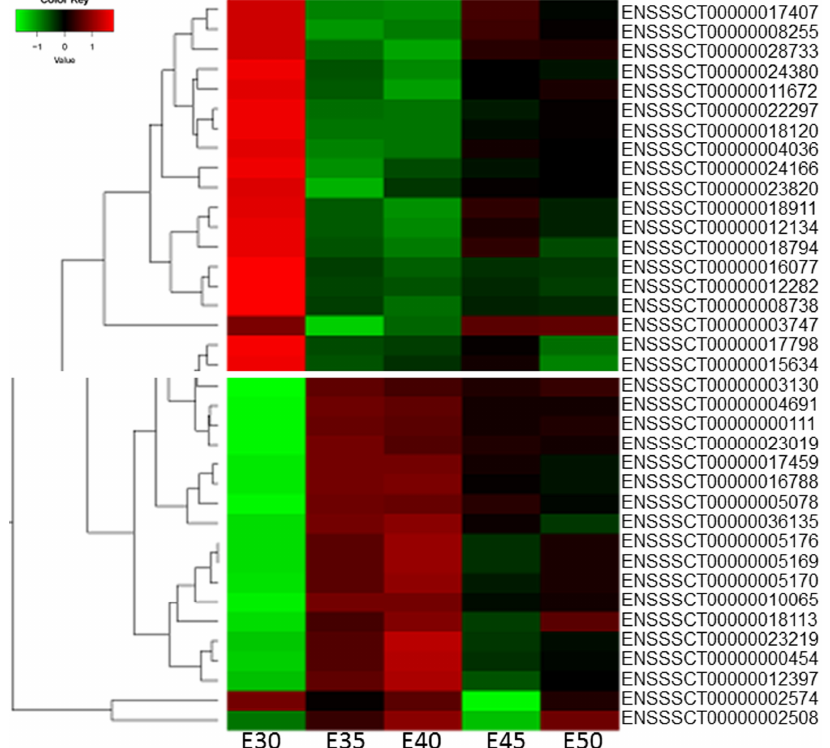
Figure 2. Hierarchical cluster analysis for differentially expressed genes (DEGs) showed different expression levels from stages E30 to E50.